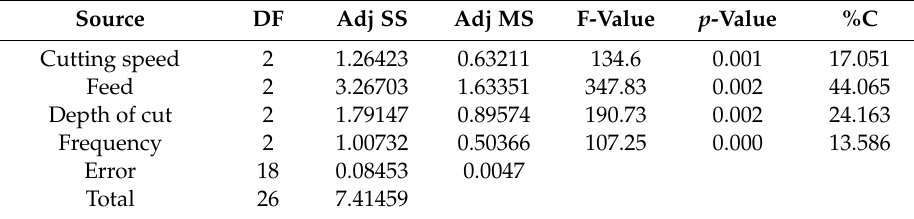
Table 5. Analysis of variance of means for surface roughness.